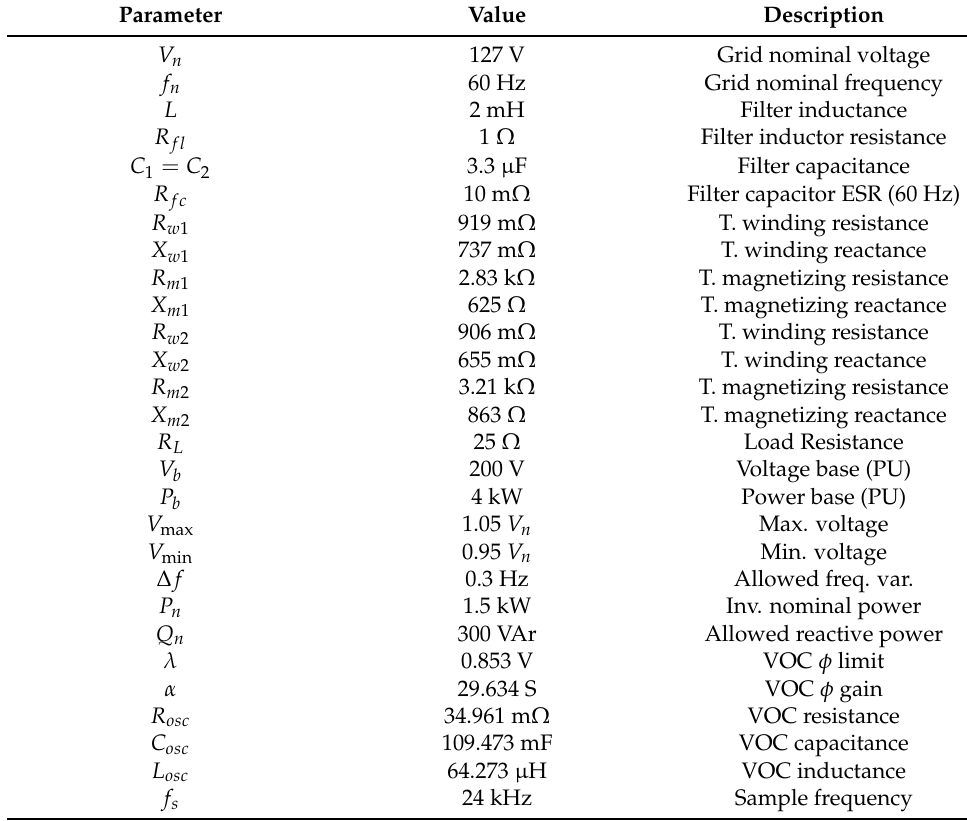
Table 9. Parameters of the experimental